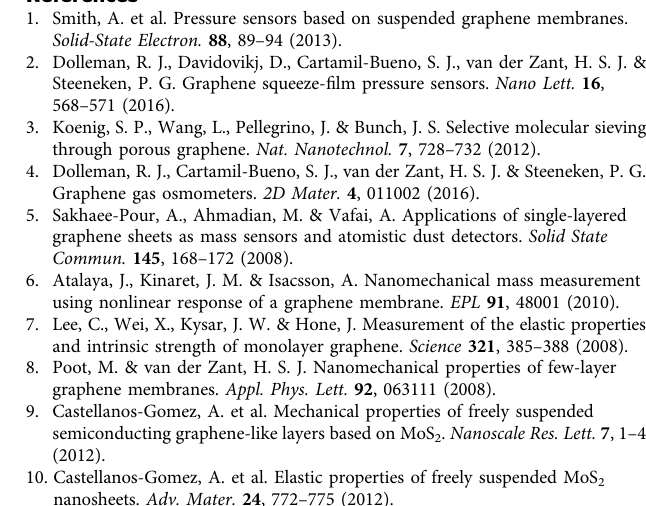
Fig. 6 Analysis of the robustness and repeatability of the method using a second graphene drum (device 4). a Extracted Young ’ s modulus as a function of applied dc voltage (blue dots: positive V dc , red dots: negative V dc ). The dashed line represents the average value of the Young and the green area represents the error in the measurement (2 σ E ). Each dot represents an extracted value from fi tting eight nonlinear response curves at different driving powers. b A histogram of the values extracted from a . The red line is a Gaussian fi t to the data. c Measurement (black dots) and fi t (drawn red curves: stable solutions; dashed red curves: unstable solutions) of the nonlinear dynamic response of device 4, using the average value of the Young ’ s modulus from a , b : 559